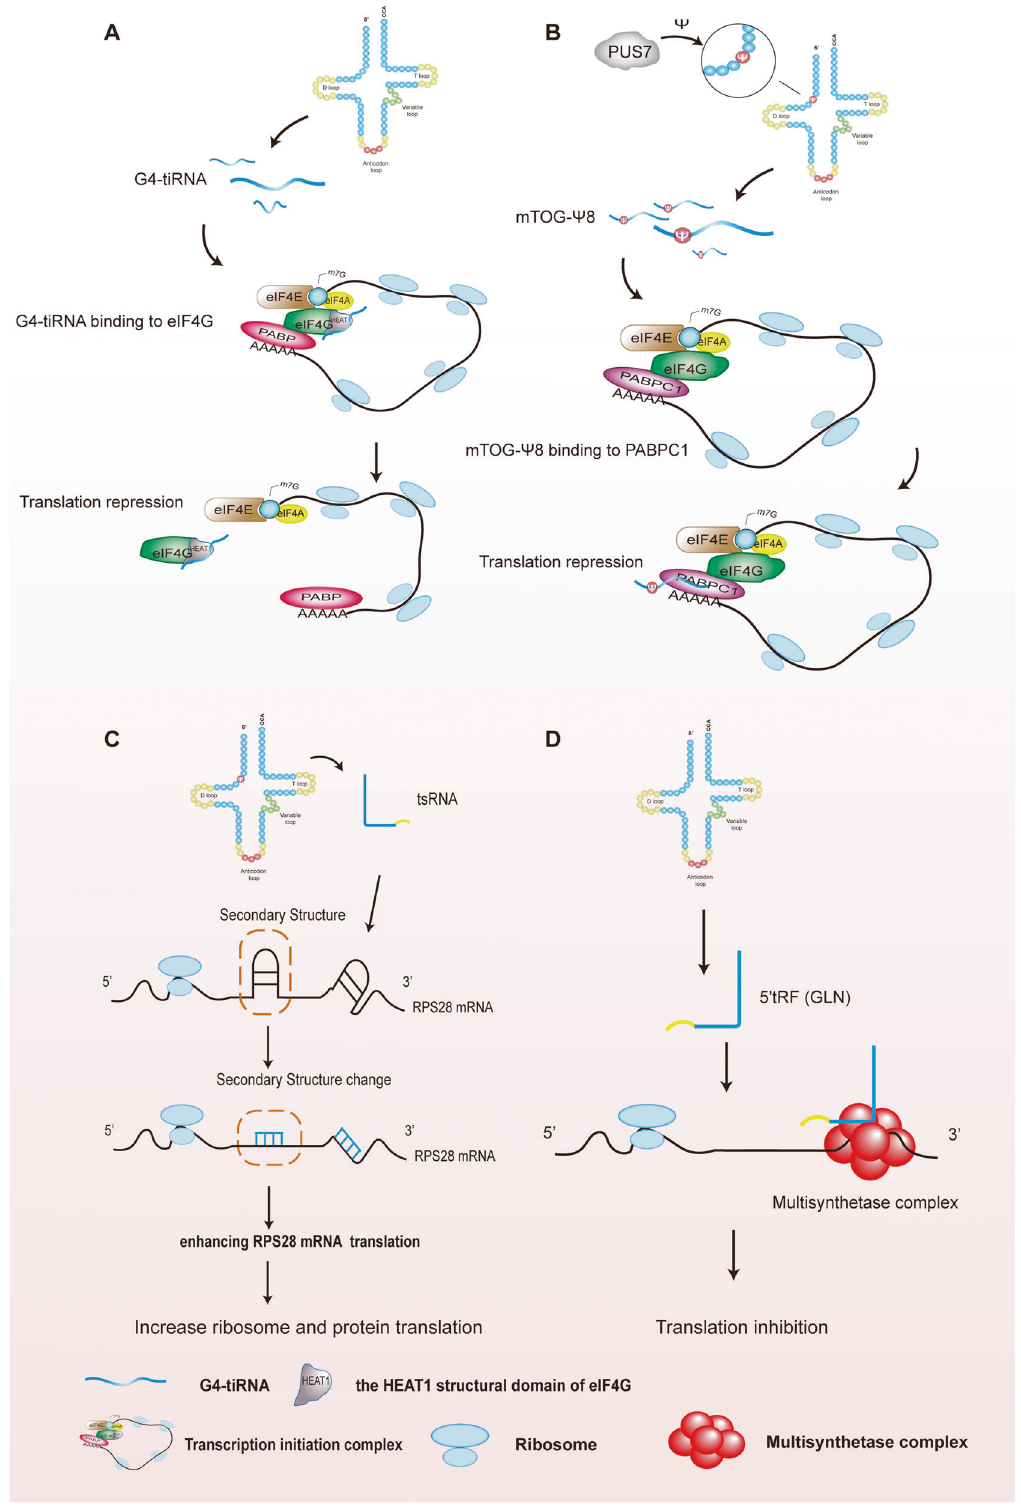
Fig. 4 tsRNAs regulate translation. A The binding of G4-tiRNA to the HEAT1 domain of the translation initiation factor, eIF4G, inhibits translation initiation. B PUS7 modi fi es tRNA position 8 containing sequences of mTOGs to pseudouridine ( Ψ ), and this speci fi c mTOG- Ψ 8 is able to bind to the translation initiation factor, PABPC1, thereby inhibiting translation initiation. C tsRNA alters the secondary structures of RPS28 mRNA to enhance its translation and ultimately accelerates protein synthesis. D 5 ’ tRF (GLN) inhibits the translation process by binding to the multisynthetase complex